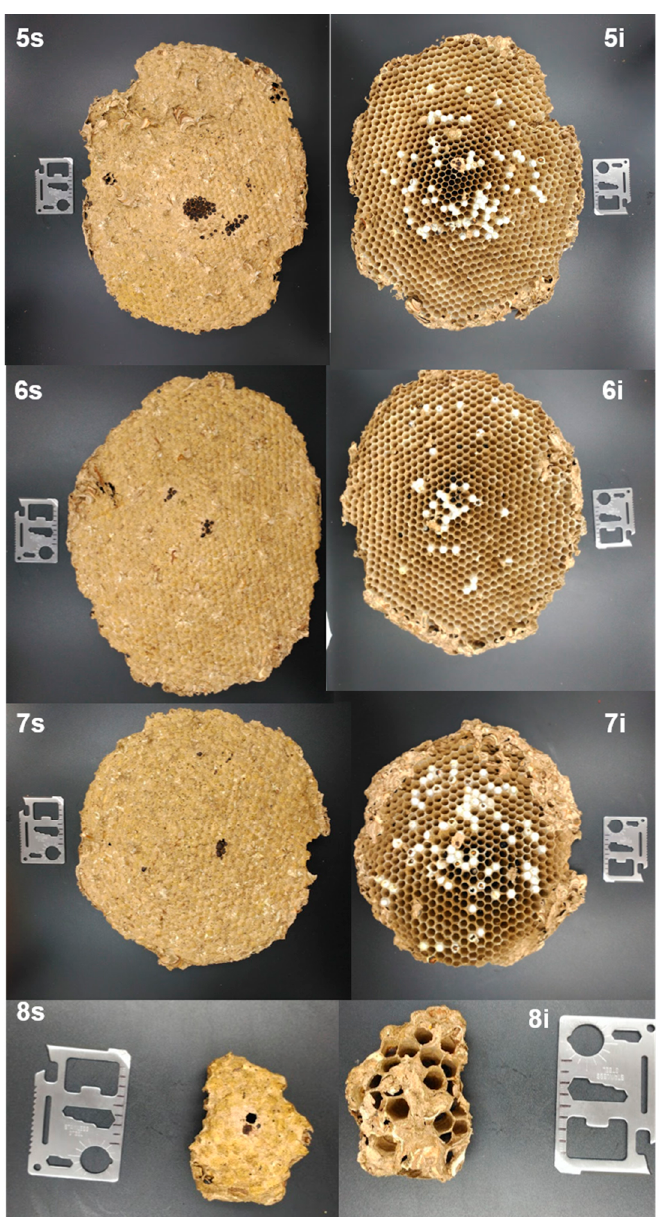
Figure 5. Combs taken from V. velutina nest C. The figures show both superior (s) and inferior (i) views of the combs (n = 8) labeled from top to bottom (1–8) in the same order they were found within the nest. The metal piece shown in each figure is 6 cm in length. Table 2. Internal nest structural features. Number of the combs (N C ), with their maximum (L C-max ) and minor (L C-min ) length, and number of pillars (N P ). Surface of the combs (S C ). Total surface of the combs (TS C ). Total cells (TC N ) of V. velutina nests studied. Nest A Nest B Nest C Comb num. L C-max L